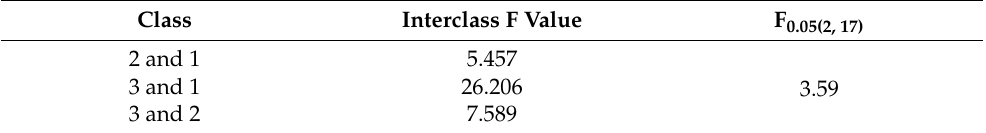
Table 5. F-test for the discrimination effect of water sample in the mining